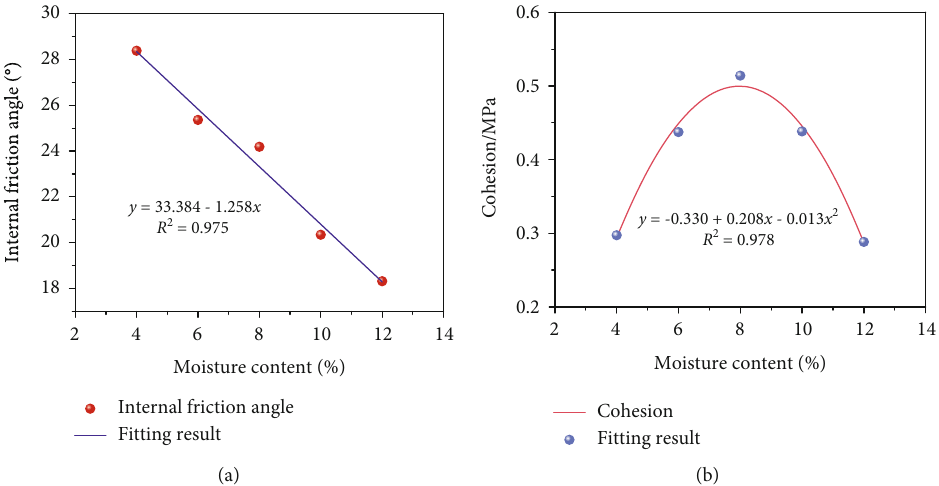
Figure 7: Relationship between moisture content and internal friction angle and cohesion. (a) Change of internal friction angle with moisture content. (b) Change of cohesion with moisture